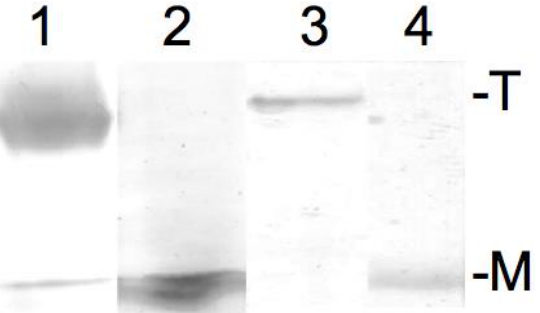
Figure 2. Sodium dodecyl sulfate–polyacrylamide gel electrophoresis (SDS PAGE) of 10 µL of 10 mg/mL KcsA in Dodecylmaltoside detergent at pH 5.5 (tetrameric: lane 1; monomeric after heating: lane 2) and 10 mg/mL KcsA in Dodecylmaltoside detergent at pH 8 (tetrameric: lane 3; monomeric after heating: lane 4). T = tetrameric KcsA, M = monomeric KcsA.